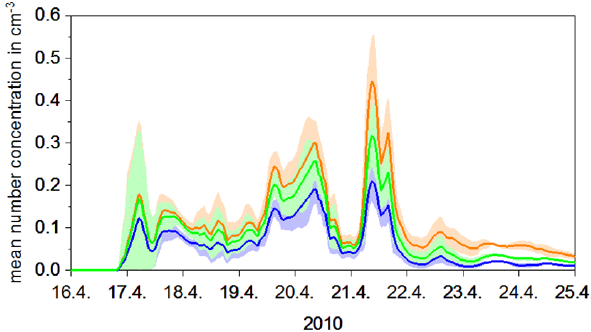
Figure 8. Simulated mean ash concentrations together with the ± σ range ( σ = standard deviation of the individual ensemble). Green: standard simulation, blue: top of the plume height at the volcano reduced by 1000m, orange: top of the plume height at the volcano increased by 1000m.